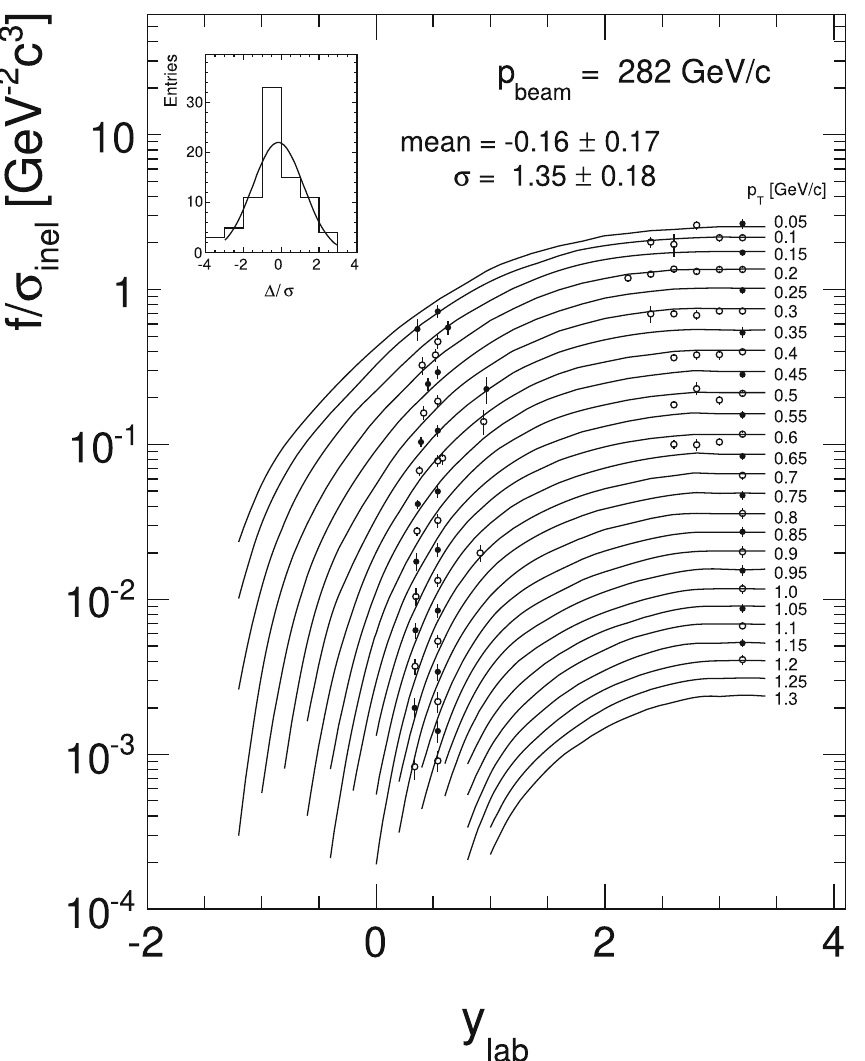
√ s of 23 GeV corresponding to a beam momentum of 282